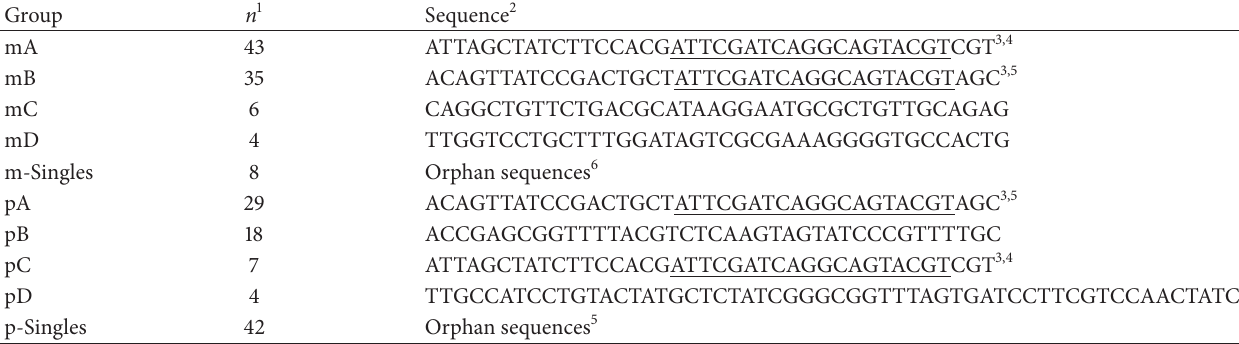
Table 2: Sequences of RNA aptamers selected following membrane- and plate-SELEX.